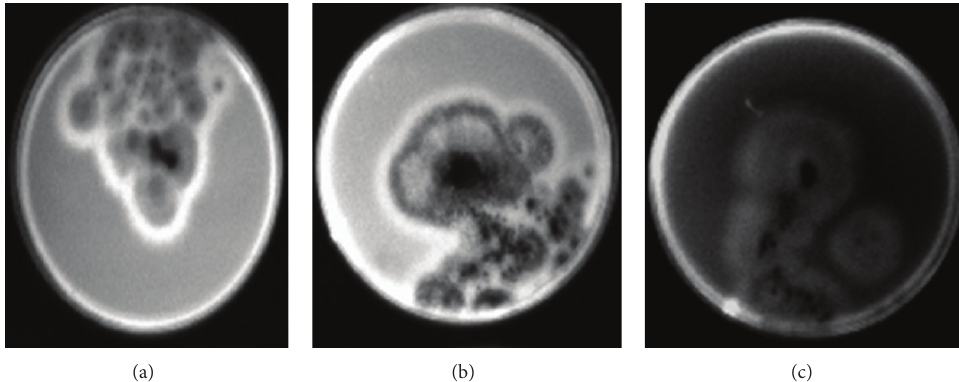
Figure 1: Aflatoxigenic strains of A. flavus (a), A. parasiticus (b), and A. niger (c) visualized under 365 nm UV light. The white ring around colonies of aflatoxigenic strains displays faint blue